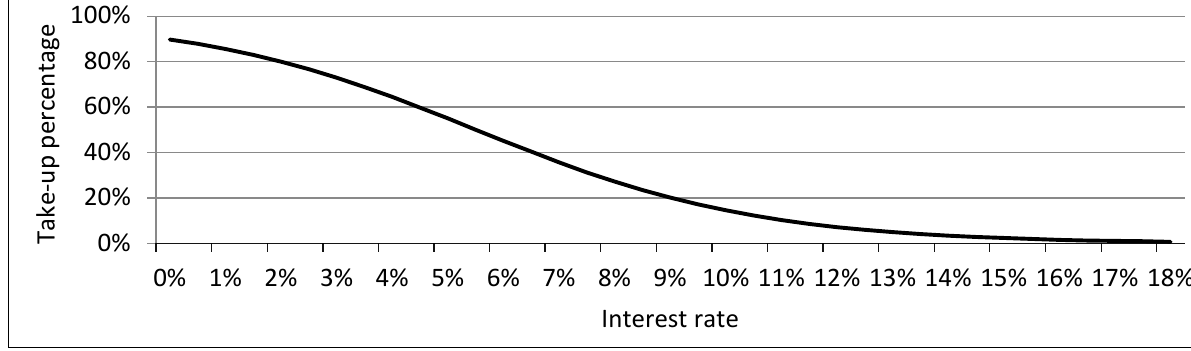
Figure 4: Probability of take-up given the interest rate offered (using logistic regression).